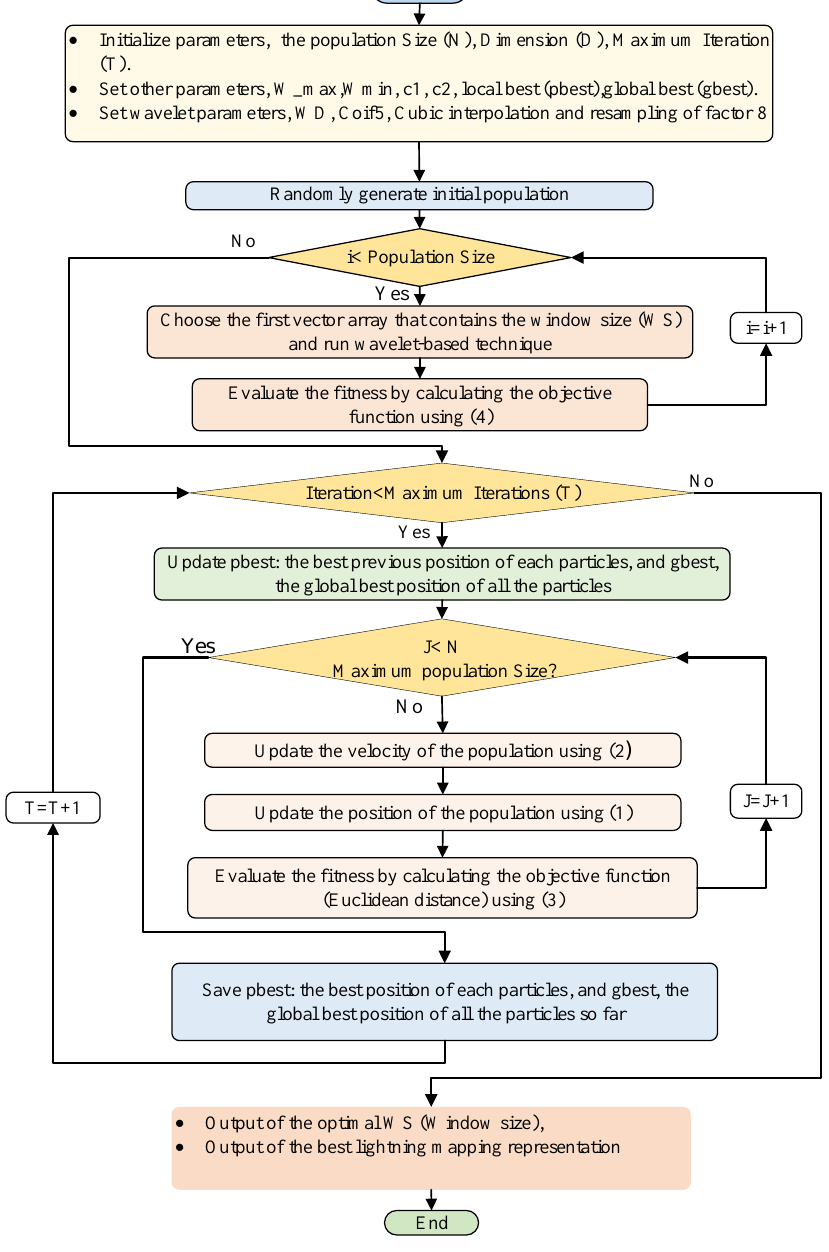
Figure 3. Flowchart of lightning mapping procedures using PSO-based algorithm.